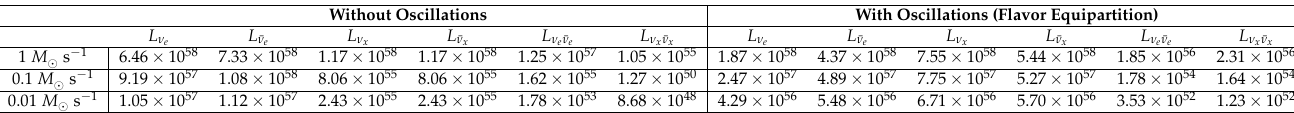
Table 3. Comparison of total neutrino luminosities L ν and annihilation luminosities L ν ¯ ν between disks with and without flavor equipartitions. All luminosities are reported in MeV s − 1 . Without Oscillations With Oscillations (Flavor Equipartition) L ν e L ¯ ν